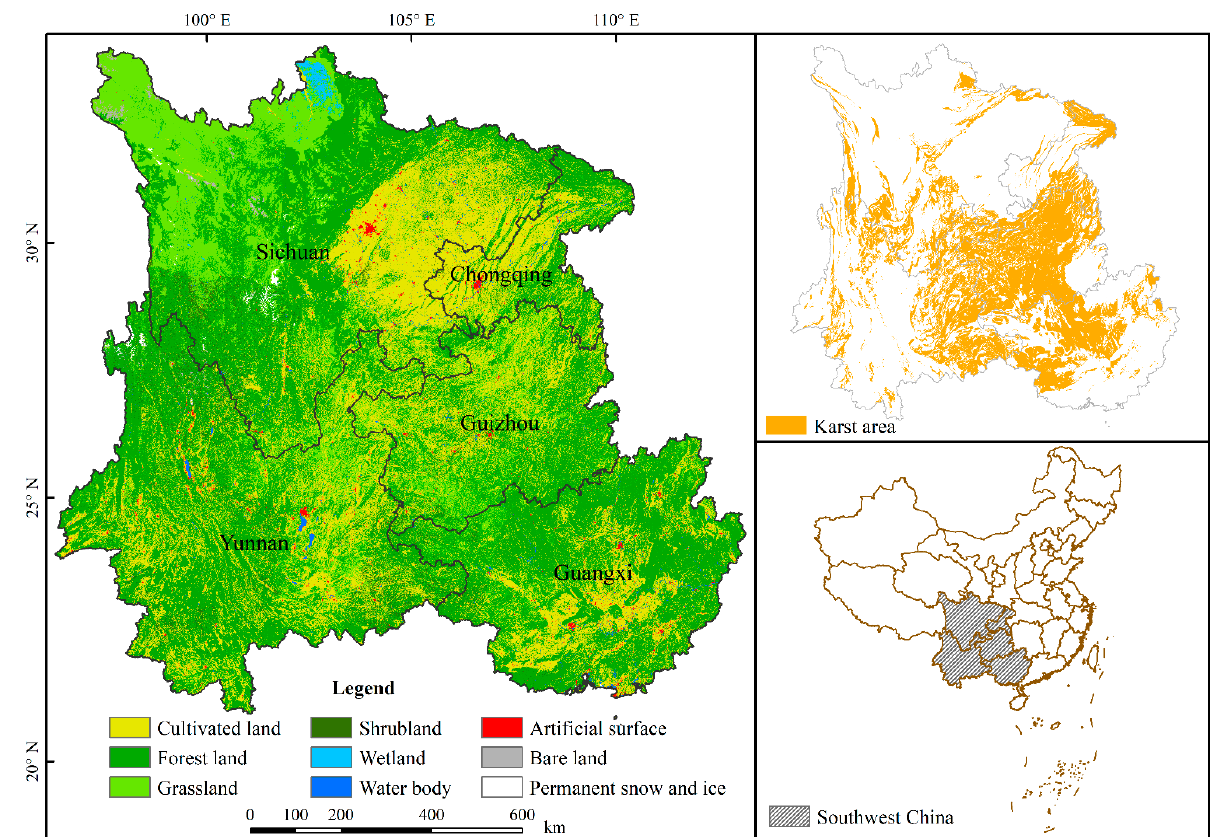
Figure 1. The map of land use/land cover in Southwest China and distribution of karst ecosystem.